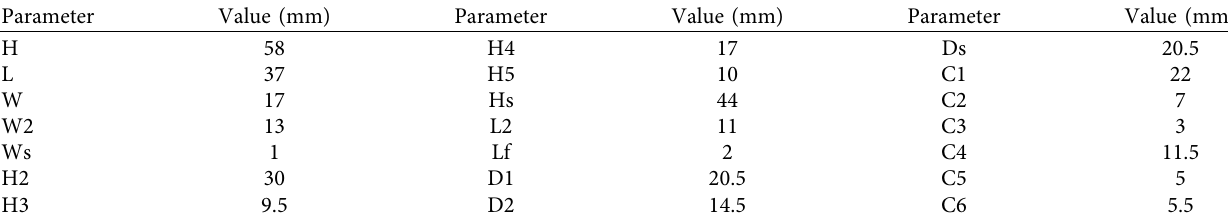
Table 1: Detailed dimensions of the monopole antenna.